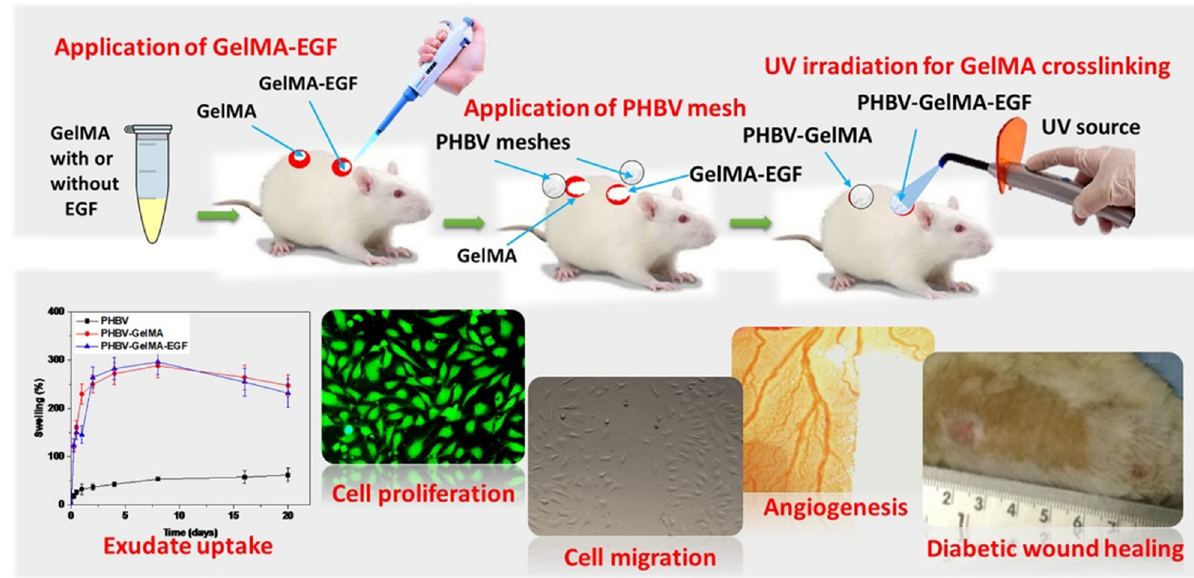
Figure 8: Schematic diagram of growth factor - loaded in situ photocrosslinkable poly ( 3 - hydroxybutyrate - co - 3 - hydroxyvalerate ) /gelatin methacryloyl hybrid patch for diabetic wound healing [ 159 ] .